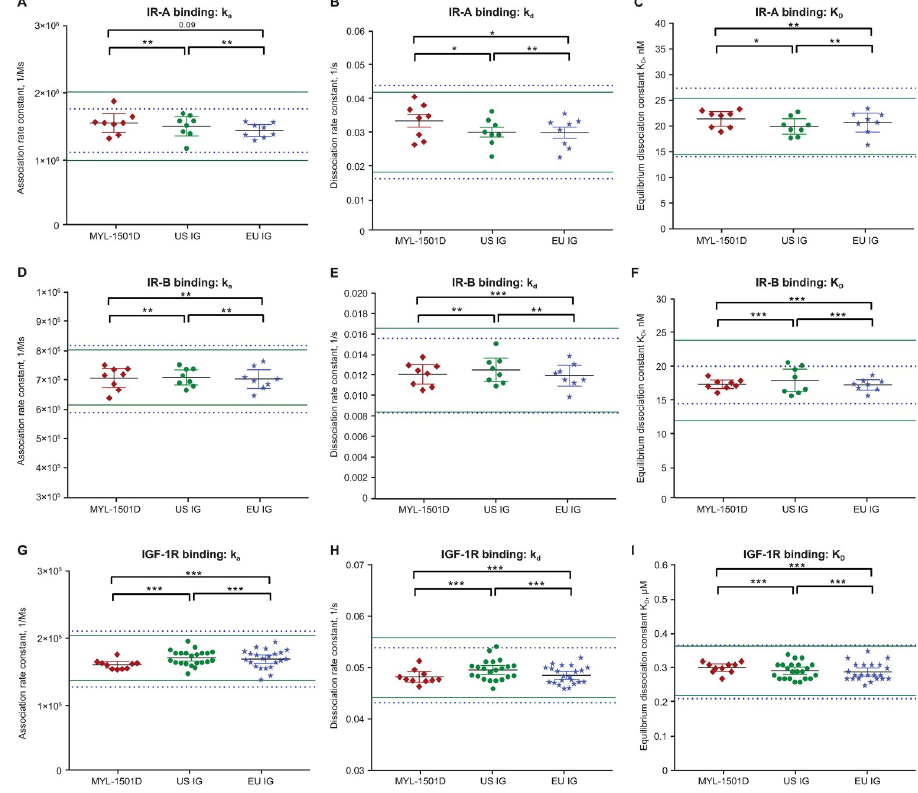
Fig 5. Scatter plot distributions of binding kinetic constants of MYL-1501D, US- and EU-licensed insulin glargine. Binding Kinetic Constants i.e., ka, kd, and K D for (A-C) IR-A (Short-Form), (D-F) IR-B (Long-Form), and (G-I) IGF-1R for MYL-1501D, US-Licensed Insulin Glargine, and EU-Licensed Insulin Glargine. Multiple lots of MYL-1501D, US-, and EU-licensed insulin glargine were analyzed, and data are expressed as mean ± 95% CI. Each dot represents one lot for which data were collected from 3 independent runs, and mean is presented. Mean ± 3 SD range derived from innovator product is presented as solid green line for US-licensed insulin glargine and dotted blue line for EU-licensed insulin glargine. � P < 0.05, �� P < 0.01, and ��� P < 0.001 in TOST/Equivalence test. IGF-1R, insulin growth factor-1 receptor; IR, insulin receptor; k a , association rate constant; k d , dissociation rate constant; K D , equilibrium dissociation constant; TOST, Two One-Sided